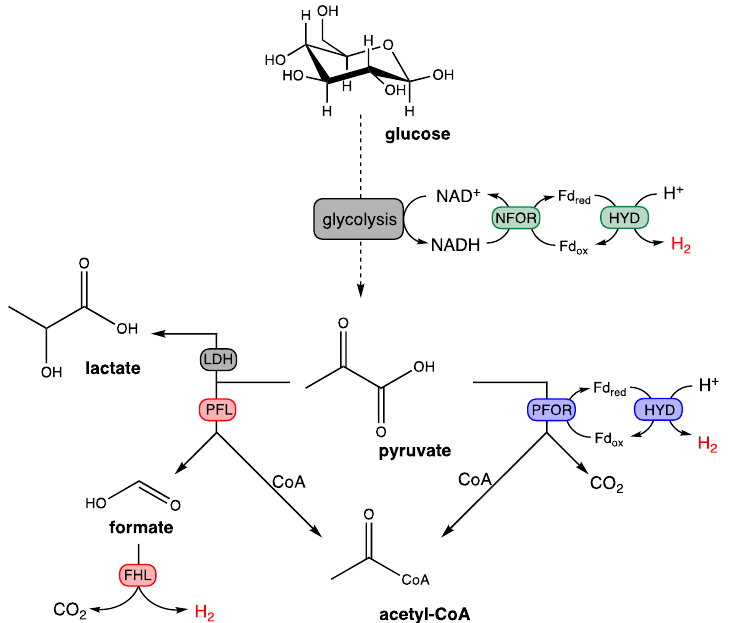
Figure 4. Dark fermentation metabolic pathways for hydrogen production. (red pathway) E. coli and Enterobacteriaceae. (blue pathway) Clostridium sp. and (green pathway) thermophilic bacteria). Abbreviations: NFOR = NADH-ferredoxin oxidoreductase, HYD = ferredoxin-dependent hydrogenase, PFOR = pyruvate-ferredoxin oxidoreductase, LDH = Lactate dehydrogenase, PFL = pyruvate-formate lyase, FHL = formate-hydrogen lyase.